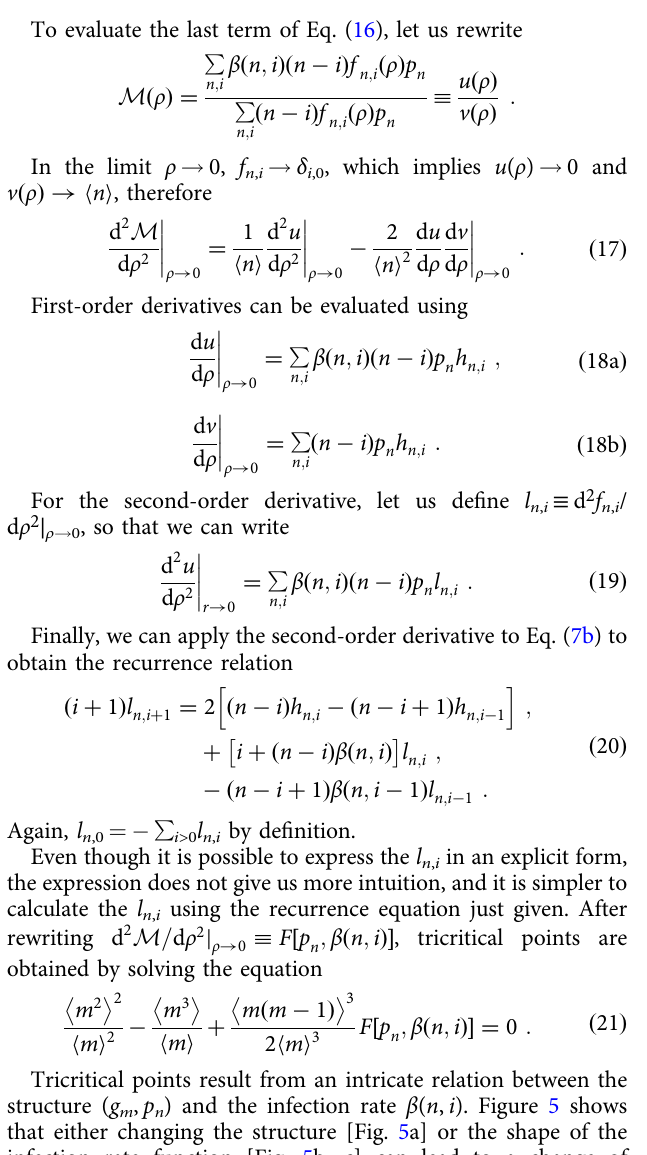
Fig. 5 Phase transition in regular hypergraphs. The membership and group size distributions are of the form ð g m ; p n Þ ¼ ð δ m ; m rate function is β ( n , i ) = λ i ν . Solid and dashed lines in a , b represent stable and unstable solutions, respectively, for the stationary fraction of infected nodes. a ν = 1.8, but different structures were used, with a node always having the same number of different neighbors. From bottom to top, we have ( g m , p n ) = ( δ m ,6 , δ n ,3 ), ( δ m ,4 , δ n ,4 ), and ( δ m ,3 , δ n ,5 ). Note that for the middle curve ( δ m ,4 , δ n ,4 ), ν c ≈ 1.81. b The hypergraph structure is fi xed with g m = δ m ,3 and (cid:4) (cid:5) p n = δ n ,4 . Values of ν 2 1 : 5 ; 1 : 7 ; ν c ; 2 : 1 ; 2 : 3 (bottom to top curves) were used, with ν c ≈ 1.91. c Phase diagram for the same hypergraph as in b . The dashed critical line ( λ = λ p ) and the solid critical line ( λ = λ c ) coalesce at the tricritical point ( λ c , ν c ) indicated by the